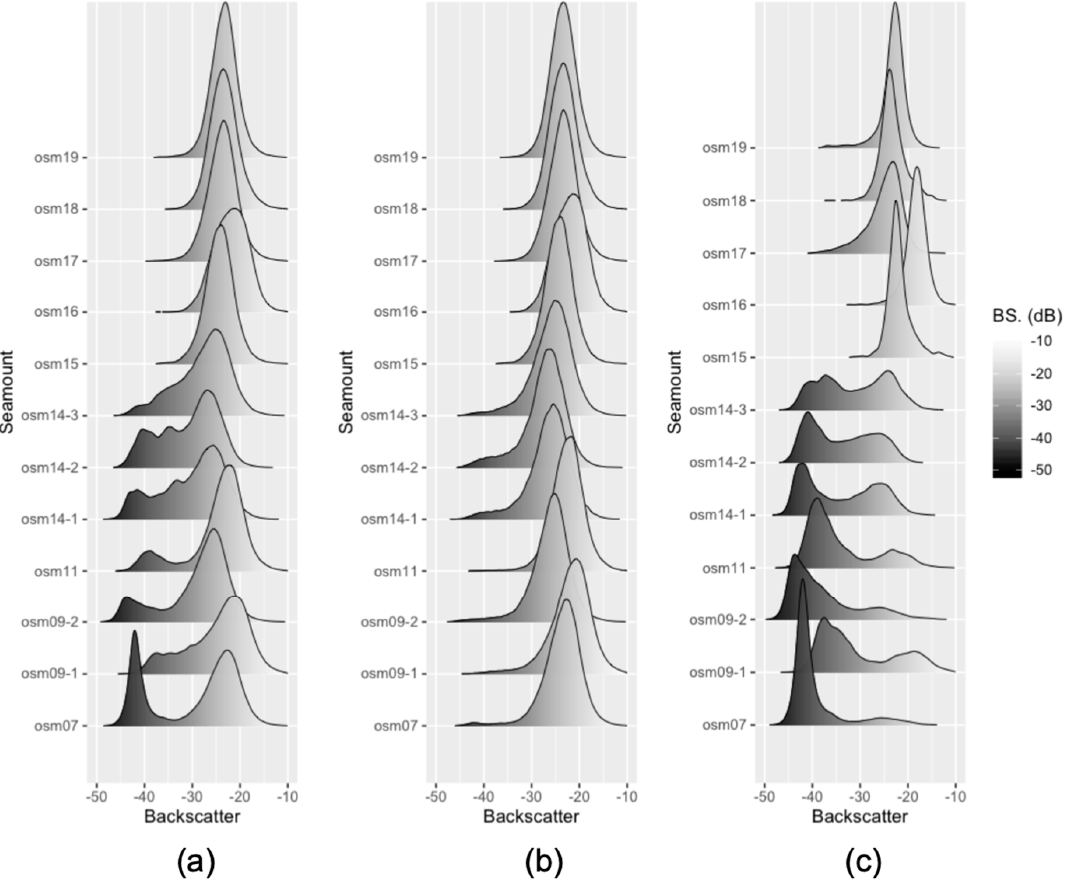
Figure 5. Multiple histograms of multibeam echo sounder (MBES) backscatter data extracted by the distinguished areas associated with ( a ) whole seamount, ( b ) flank area only, and ( c ) summit area only of target’s seamounts.